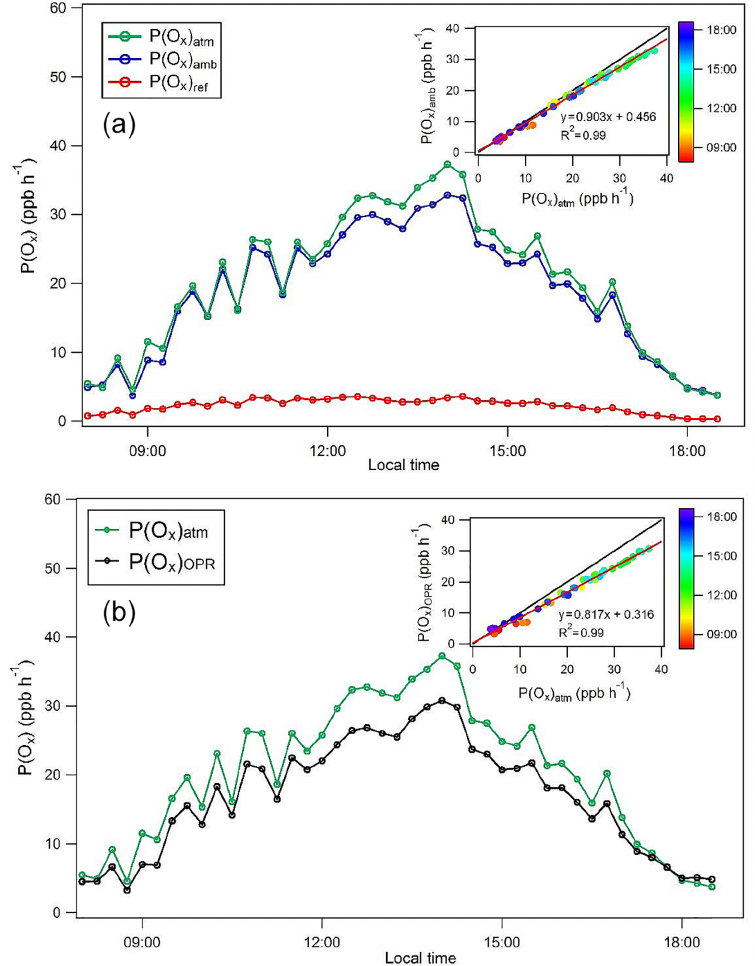
Figure 6. Modeling comparison of P (O x ) values. (a) Ozone production rates modeled for the atmosphere, P (O x ) atm ; the ambient flow tube, P (O x ) amb ; and the reference flow tube, P (O x ) ref , for 30 May 2010 of the CalNex 2010 campaign. (b) Comparison of modeled ozone production rates for the OPR, P (O x ) OPR , and the atmosphere, P (O x ) atm , for 30 May 2010. Inserts: correlations between P (O x ) atm and P (O x ) amb (a) as well as between P (O x ) atm and P (O x ) OPR (b) , color-coded by the time of